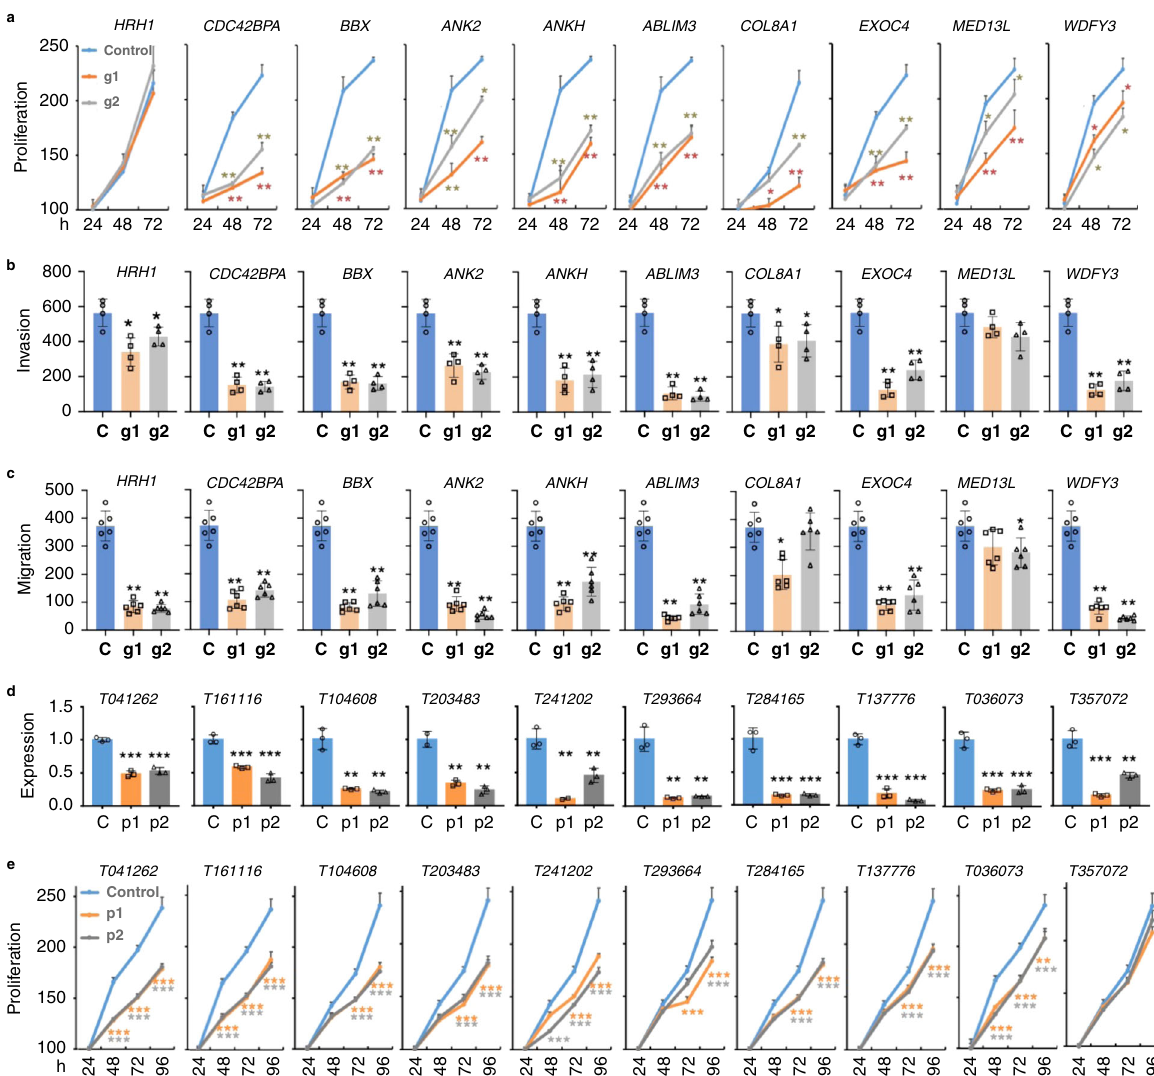
Fig. 7 Depletion of putative tumor-promoting genes and lncRNAs identi fi ed using BGRD signature impaired cancer phenotypes of tumor cells. Proliferation ( a ), transwell invasion ( b ), and migration ( c ) of breast cancer cell MDA-MB-231 with each putative tumor-promoting gene disrupted by CRISPR-Cas9 guide RNA g1, g2, or under control condition. LncRNA expression level ( d ) and cell proliferation rate of breast cancer cell MDA-MB-231 ( e ) with each candidate tumor-promoting lncRNA disrupted by CRISPR-Cas9 guide RNA pairs p1, p2, or under control condition. All the data were analyzed from at least three independent experiments and the quanti fi cation results were expressed as mean ± SD. P values determined by two tails Student ’ s t test and the exact P values were listed in the Source data; *** P < 0.001; ** P < 0.01; * P < 0.05; For proliferation, n = 5; for migration, n = 6; for invasion, n = 4; for lncRNA expression level, n = 3. C: control; KO: knockout; g1: guide RNA #1; g2: guide RNA #2; P1: guide RNA pair #1; P2: guide RNA pair #2. Source data are provided as a Source Data fi